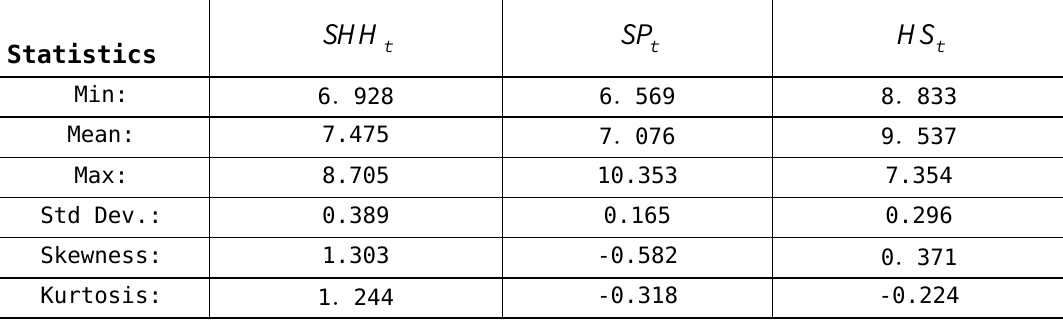
Table 1: Descriptive statistics of